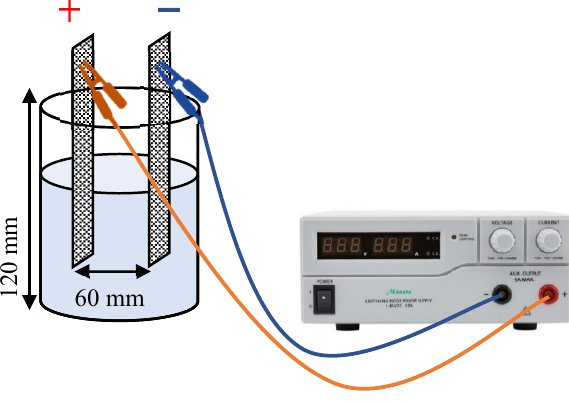
Figure 1. Electrochemical reactor setup.